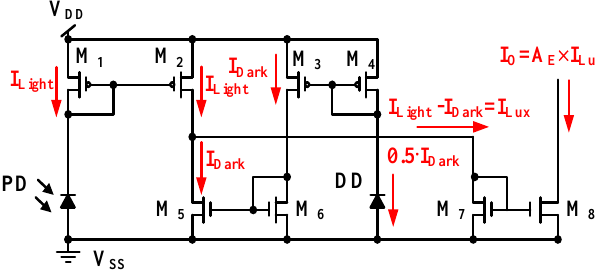
Figure 8. CA with enhanced dark current cancellation.